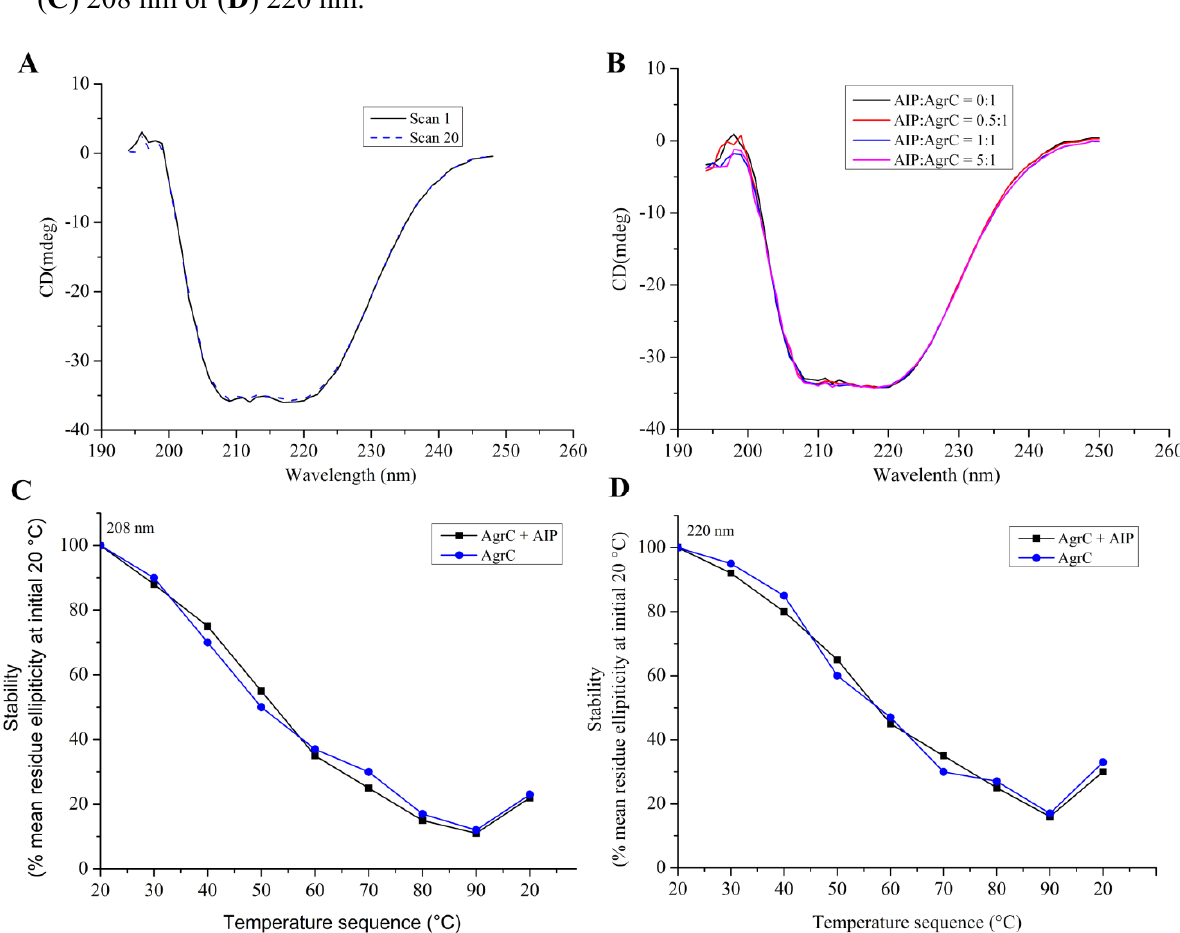
Figure 6. Determination of AgrC stability from CD measurements. ( A ) Far UV spectra of purified AgrC before and after exposure to far UV radiation following sample preparation in 10 mM 4-(2-hydroxyethyl)-1-Piperazineethanesulfonic acid (HEPES) (pH 7.4) containing 10× CMC Brij-35, 100 mM NaCl, and 10% glycerol at 20 °C. Spectrum 1, immediately after stabilization (solid line); spectrum 20, after 1 h exposure to light radiation (190–250 nm) during 19 consecutive scans (dashed line); ( B ) Spectra of stabilized AgrC in the presence of AIP-I. Data from each individual scan (unsmoothed) are shown; ( C and D ) Thermal stability of AgrC in the presence or absence of two-fold molar excess of AIP-I was expressed as % initial mean residue ellipticity obtained at 20 °C and ( C ) 208 nm or ( D ) 220